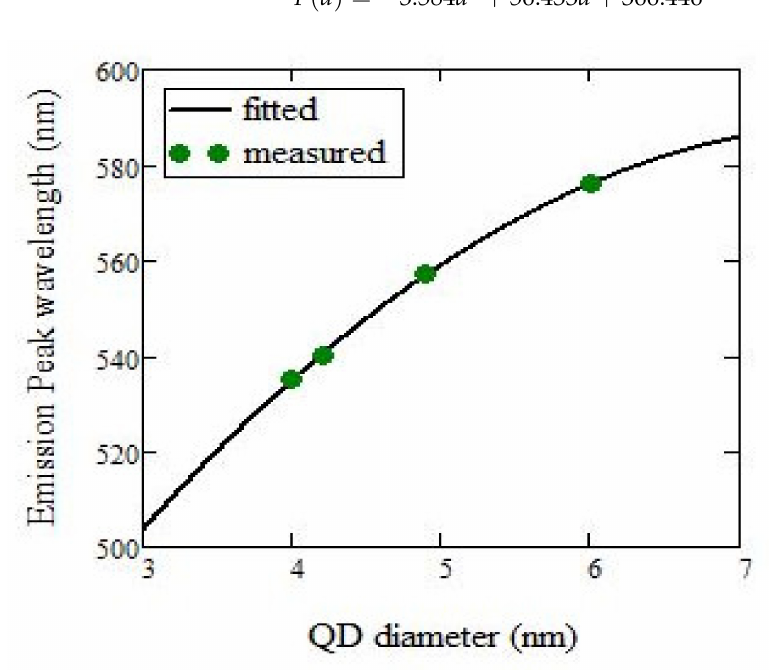
Figure 4. From these experimental data, an empirical fitting equation has been reproduced to express the relation between the diameter of QD ( d ) and the position of the emission peak wavelength P ( d ):